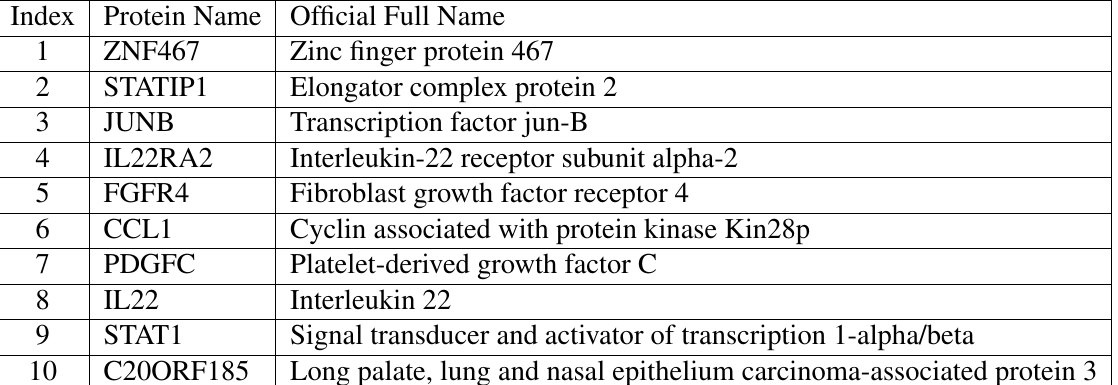
Table 7: Most discriminative proteins based on ANOVA